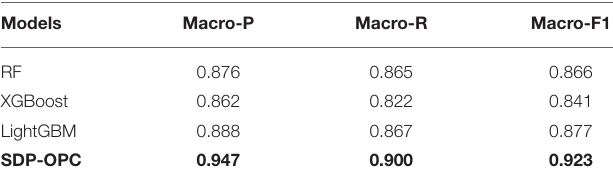
TABLE 5 | Comparison of different temporal encoders. TABLE 7 | Comparison of SDP-ODC and benchmark models.